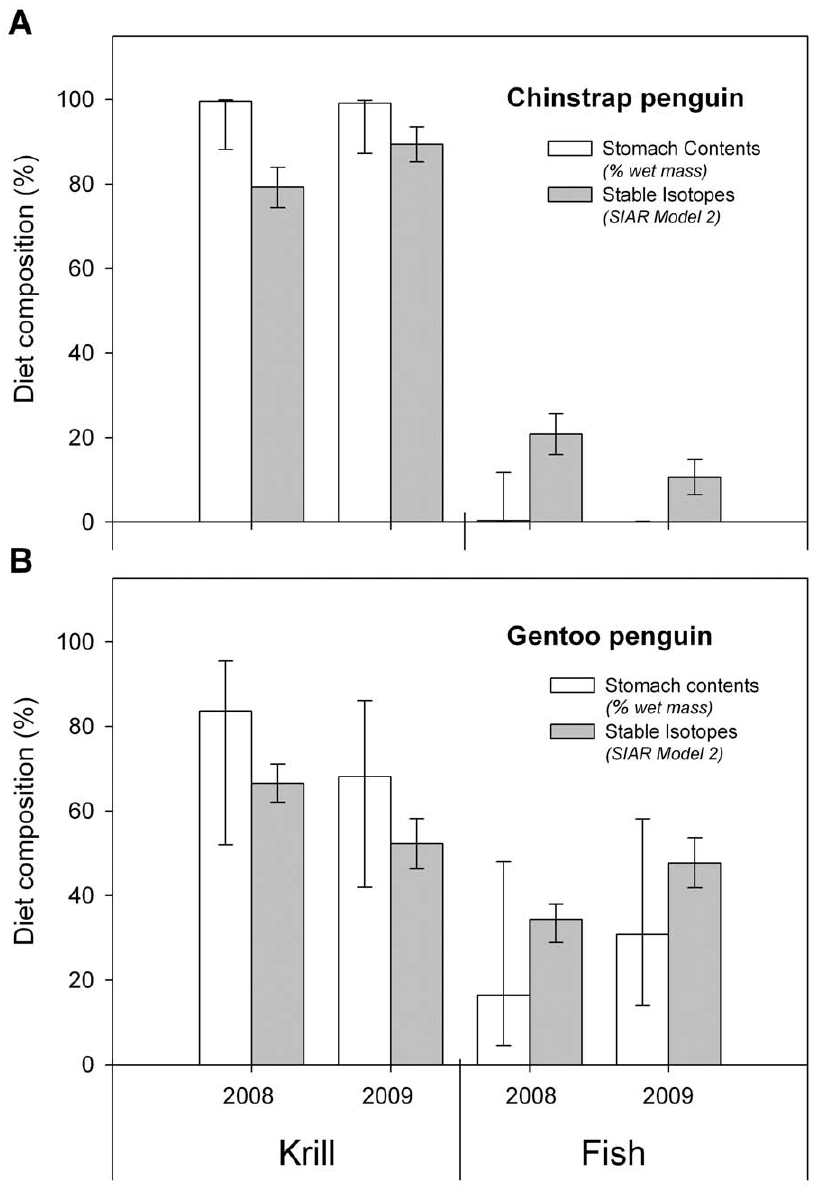
Figure 2. The estimated diet composition of penguin chicks based on stomach content and stable isotope analysis. Stomach content proportions are calculated as a percent of wet mass and proportion estimates of krill vs. fish using stable-isotope analysis are derived from a two- source Bayesian mixing model SIAR (Model 2) using annually weighted ‘‘fish’’ values listed in table S2 [21]. Proportions are presented mean 6 Bayesian 95% credibility